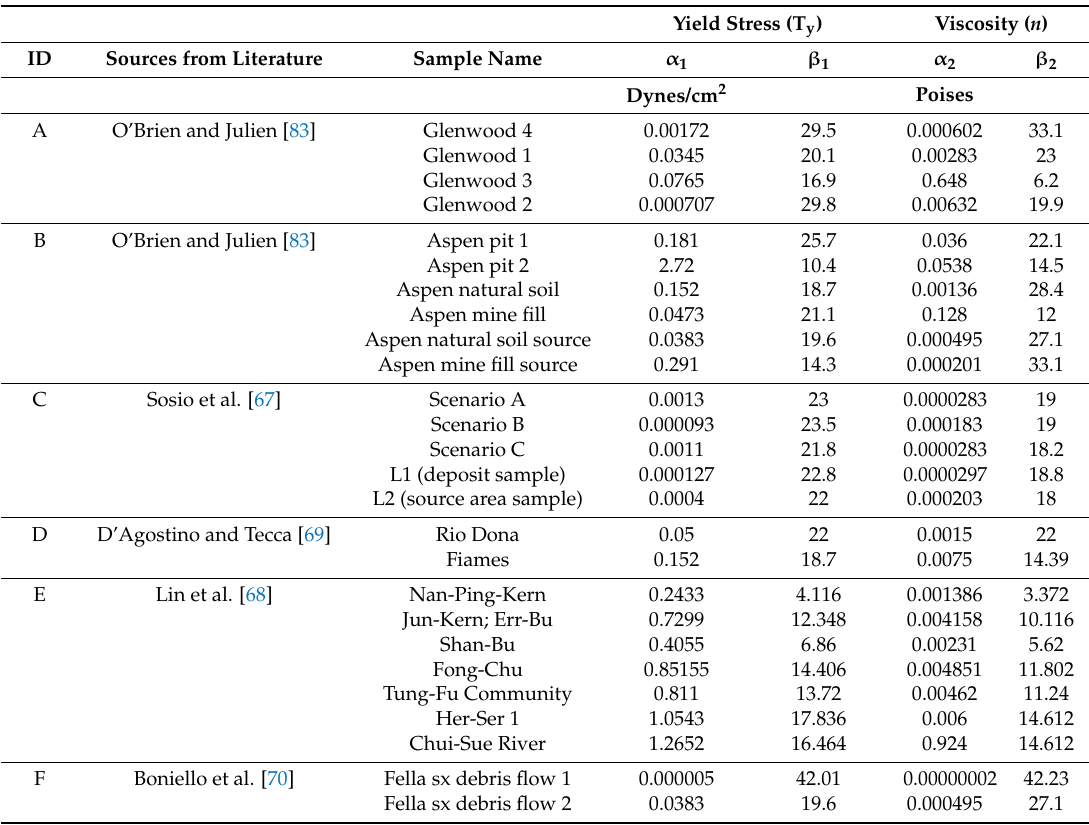
Table 3. Summary of selected rheological values from the literature to evaluate with the FLO-2D model with respect to the 2005 debris flow event, in lieu of location-specific post-event field samples; a unique ID is assigned to each group of